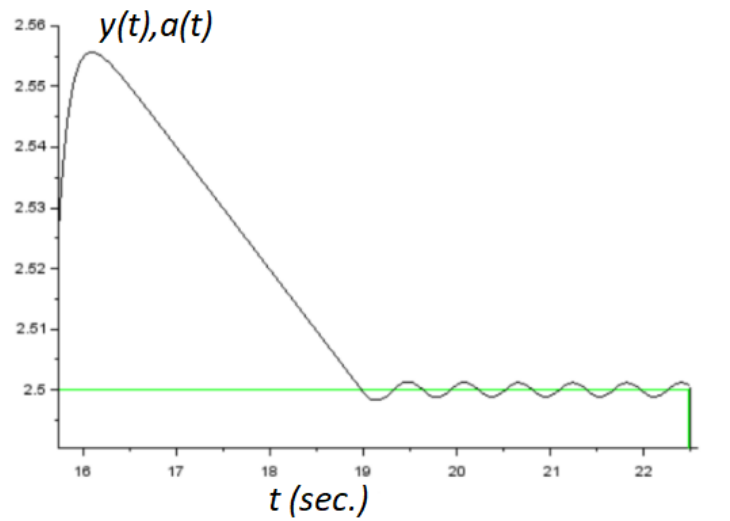
Figure 7. An enlarged view of the Figure